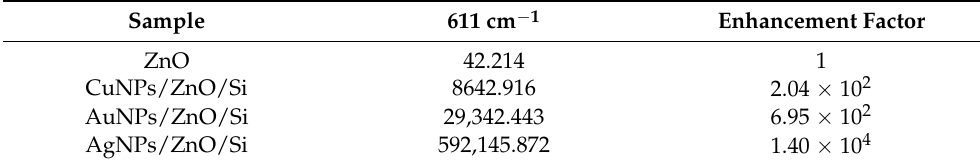
Table 4. Enhancement calculation for the different noble metal